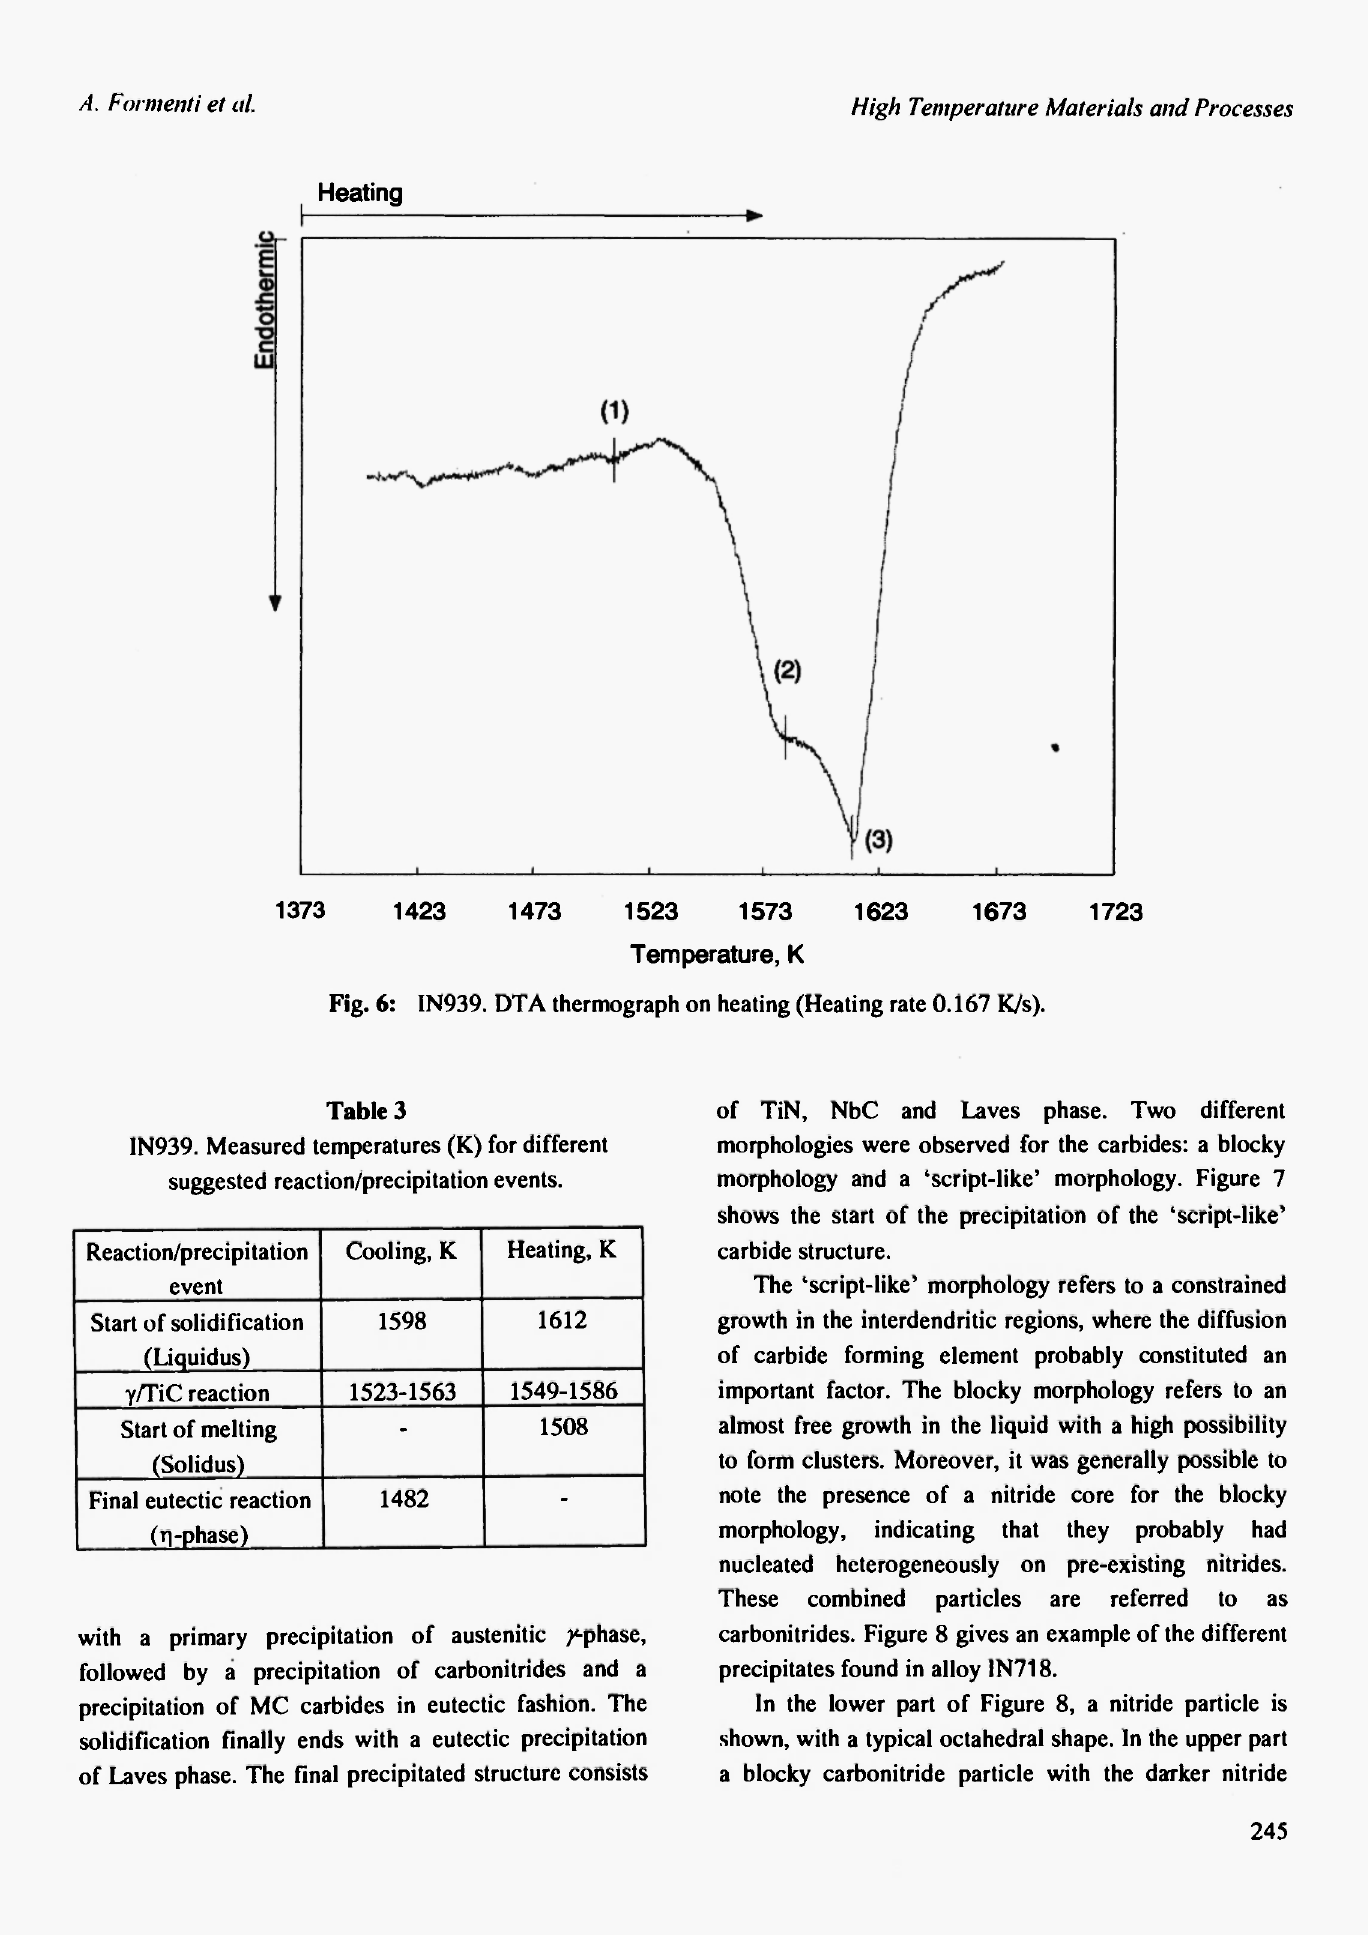
IN939. Measured temperatures (K) for different suggested reaction/precipitation